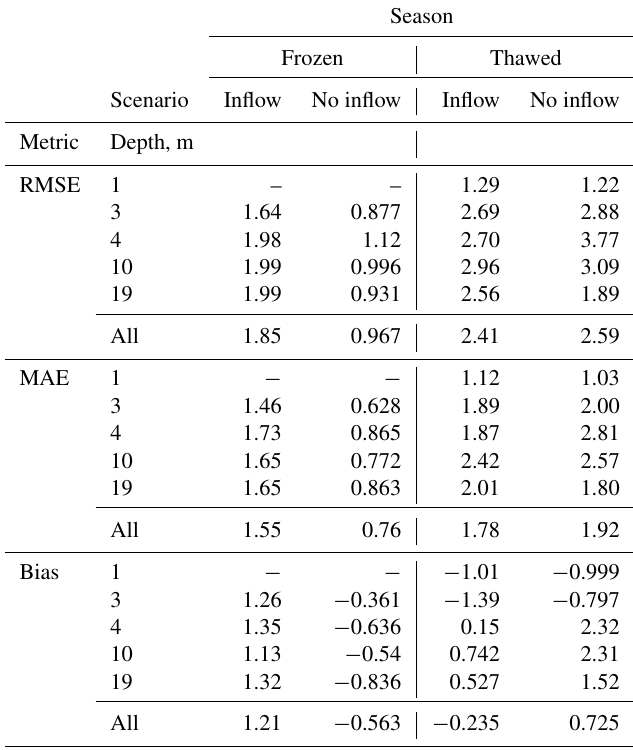
Table B2. Toolik model lake temperature errors for inflow and no inflow simulations split by